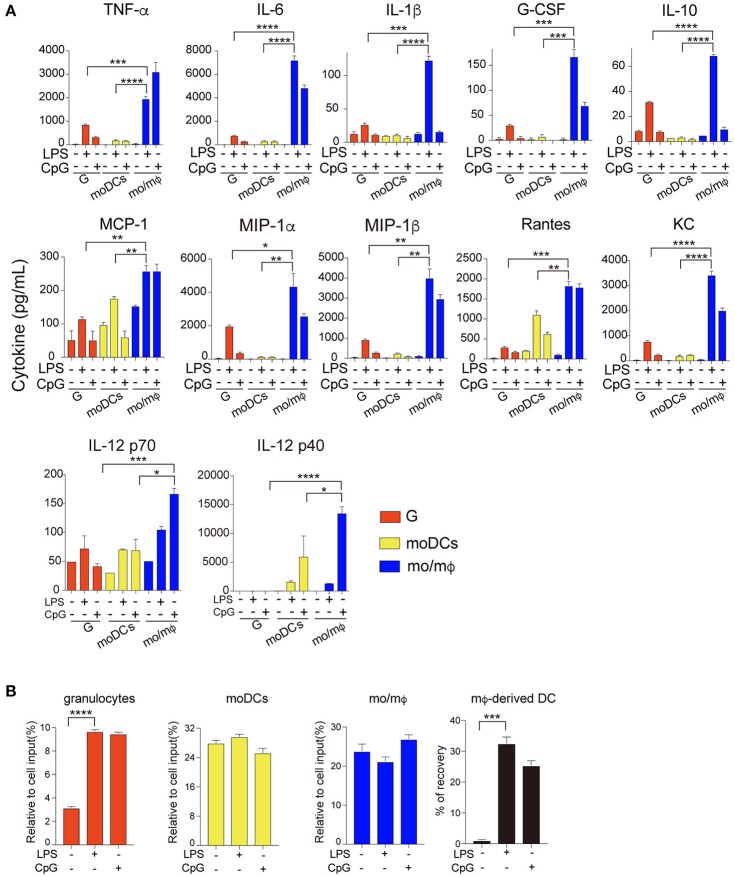
Granulocyte, moDCs, and mo/mΦ from the same cultures differ in cytokine production. After culturing with 10 ng/mL GM-CSF for 7 days in vitro, granulocytes (G), moDCs and mo/mΦ were purified by flow sorting, then stimulated by LPS (1 μg/mL) and CpG (1 μ) for 20 h. (A) Accumulation of inflammatory cytokines and chemokines in the supernatant was measured after 20 h. The concentration (pg/mL) of inflammatory cytokines and chemokines produced by the three myeloid populations are shown. (B) Plots show the percentage of cell recovery for the three populations after culturing for 20 h. *p < 0.05, **p < 0.01, ***p < 0.001, ****p < 0.0001(student's t-test).